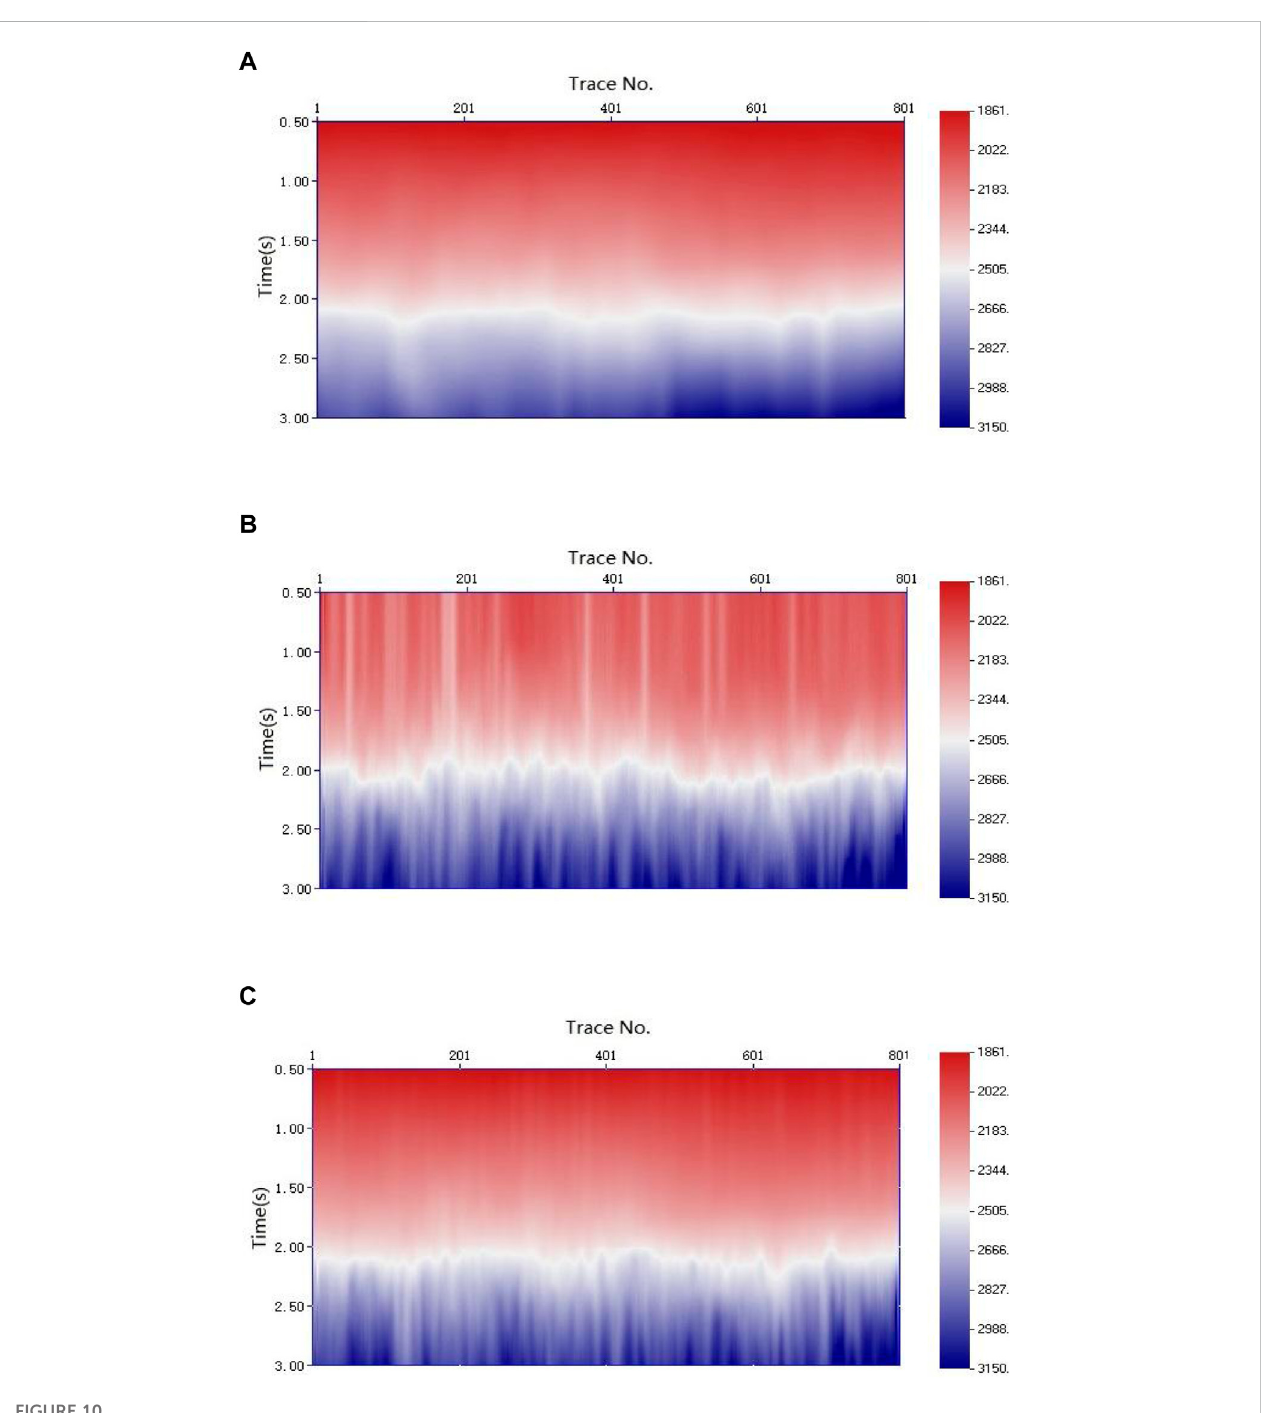
superior to the conventional k-means clustering method. In terms of computational speed, the average number of iterations for the conventional k-means clustering method was seven times per CMP, whereas that for the weighted k-means clustering method was four times per CMP. Therefore, the velocity determined by the weighted k-means clustering method is fast and